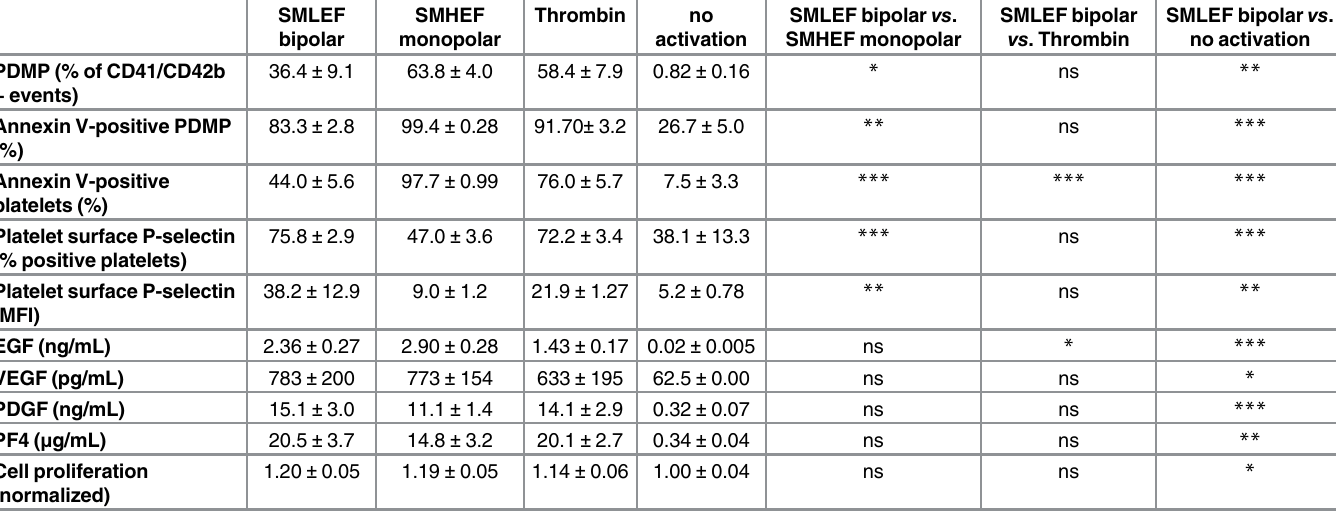
Table 1. Differential effects of SMLEF bipolar pulses, SMHEF pulses and thrombin on PRP activation, growth factor release, and cell proliferation.